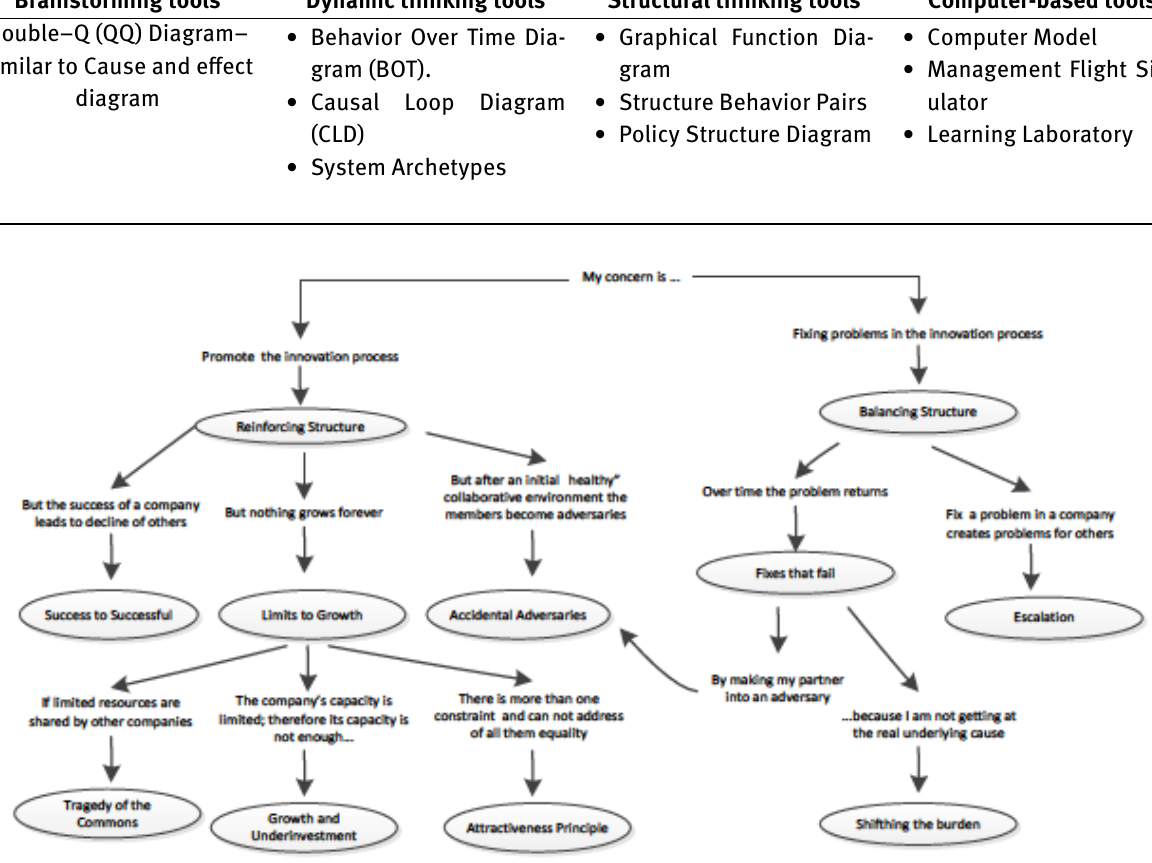
Figure 2: System Archetype